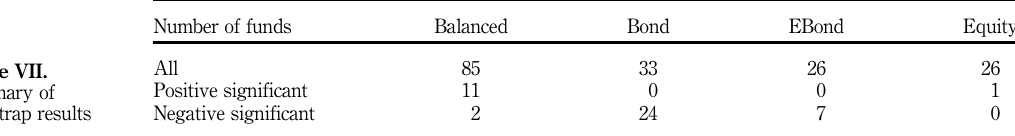
Table VII. Summary of bootstrap